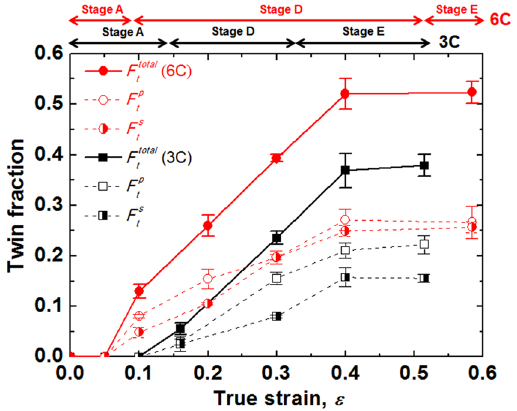
Figure 5. Variations in the fraction of total F ( ) ttotal , primary F ( ) tp and secondary F ( ) ts mechanical twins with true strain in 3C and 6C steels.